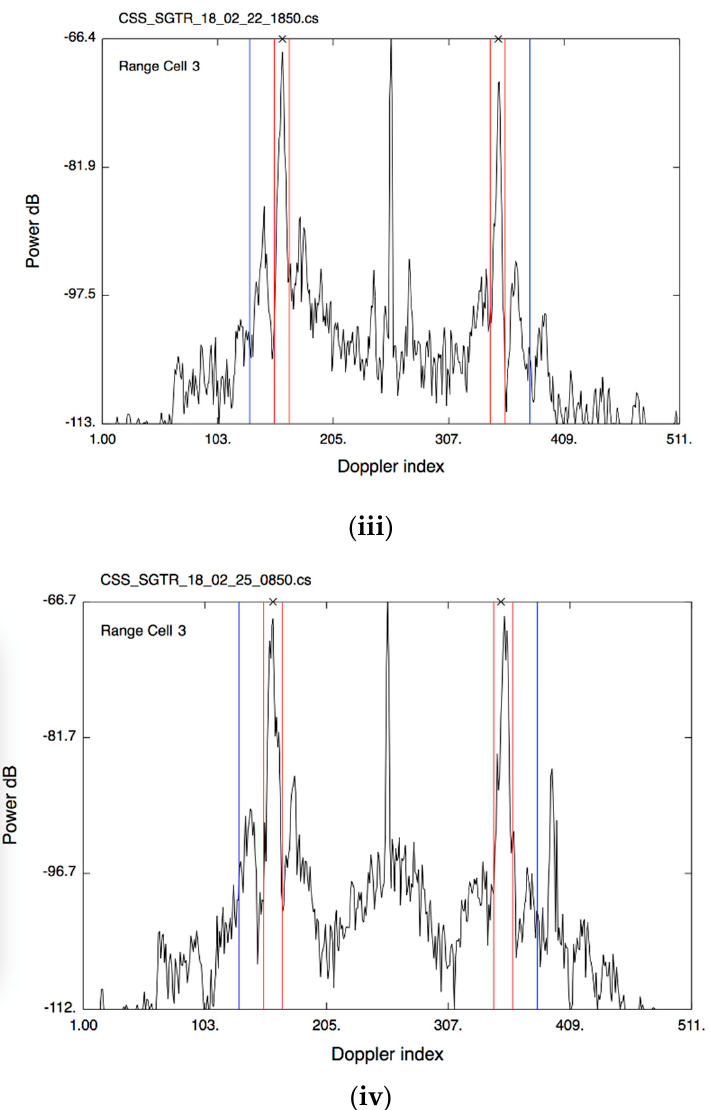
Figure 2. ( i − iv ): Examples of the division of the second-order spectrum in SeaSonde monopole spectra into separated regions due to high and low period waves. The radar Doppler spectrum contains 512 spectral points and signal strength (dB) is plotted vs. point number. The first-order region is bounded by red lines. The blue lines indicate the calculated boundaries between regions ( i , ii ). ( i ) Sagres, Portugal, 21 February 2018, 1:50 pm. Range cell 3. ( ii ) Sagres, Portugal, 21 February